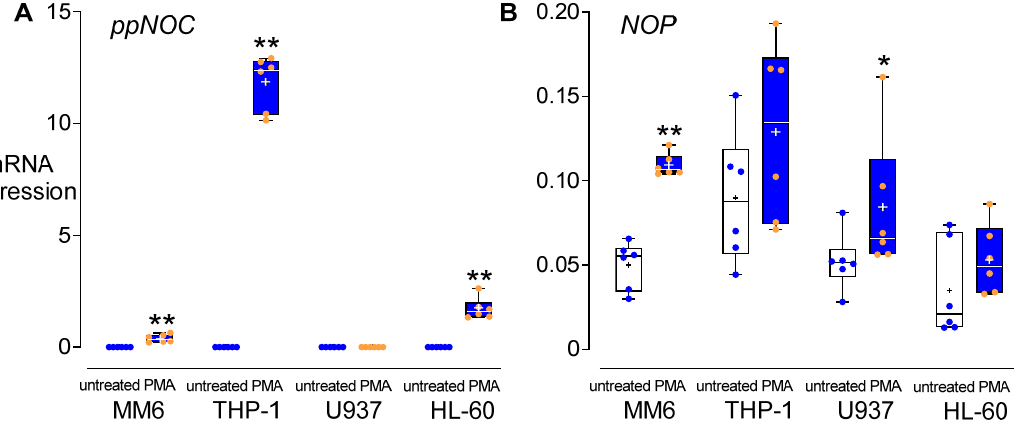
Figure 2. PMA effects on ppNOC and NOP mRNA expression in different human cell lines. Cells were treated with 5 ng/mL of PMA or without PMA (controls) for 24 h. ppNOC mRNA expression ( A ) and NOP mRNA expression ( B ) in different cell lines with or without PMA. Boxplots with individual data points, median, IQR, and mean “+”; n = 6. Wilcoxon test, *, p < 0.05; **, p < 0.01, compared to the respective controls.